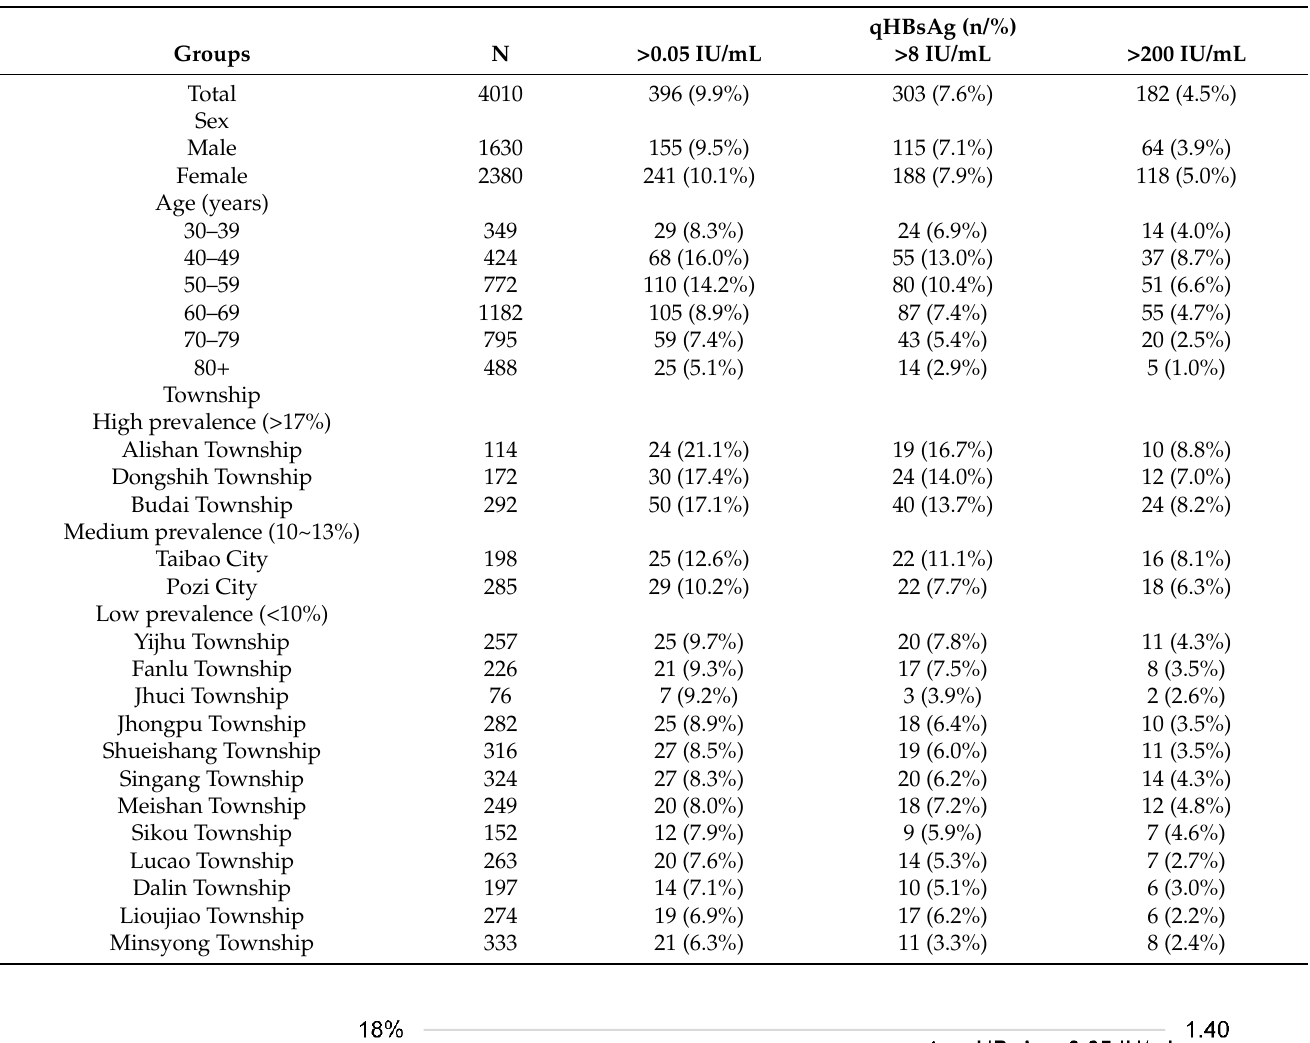
Table 1. Prevalence of quantitative HBsAg (qHBsAg) in different cutoffs grouping by sex, age, and township.